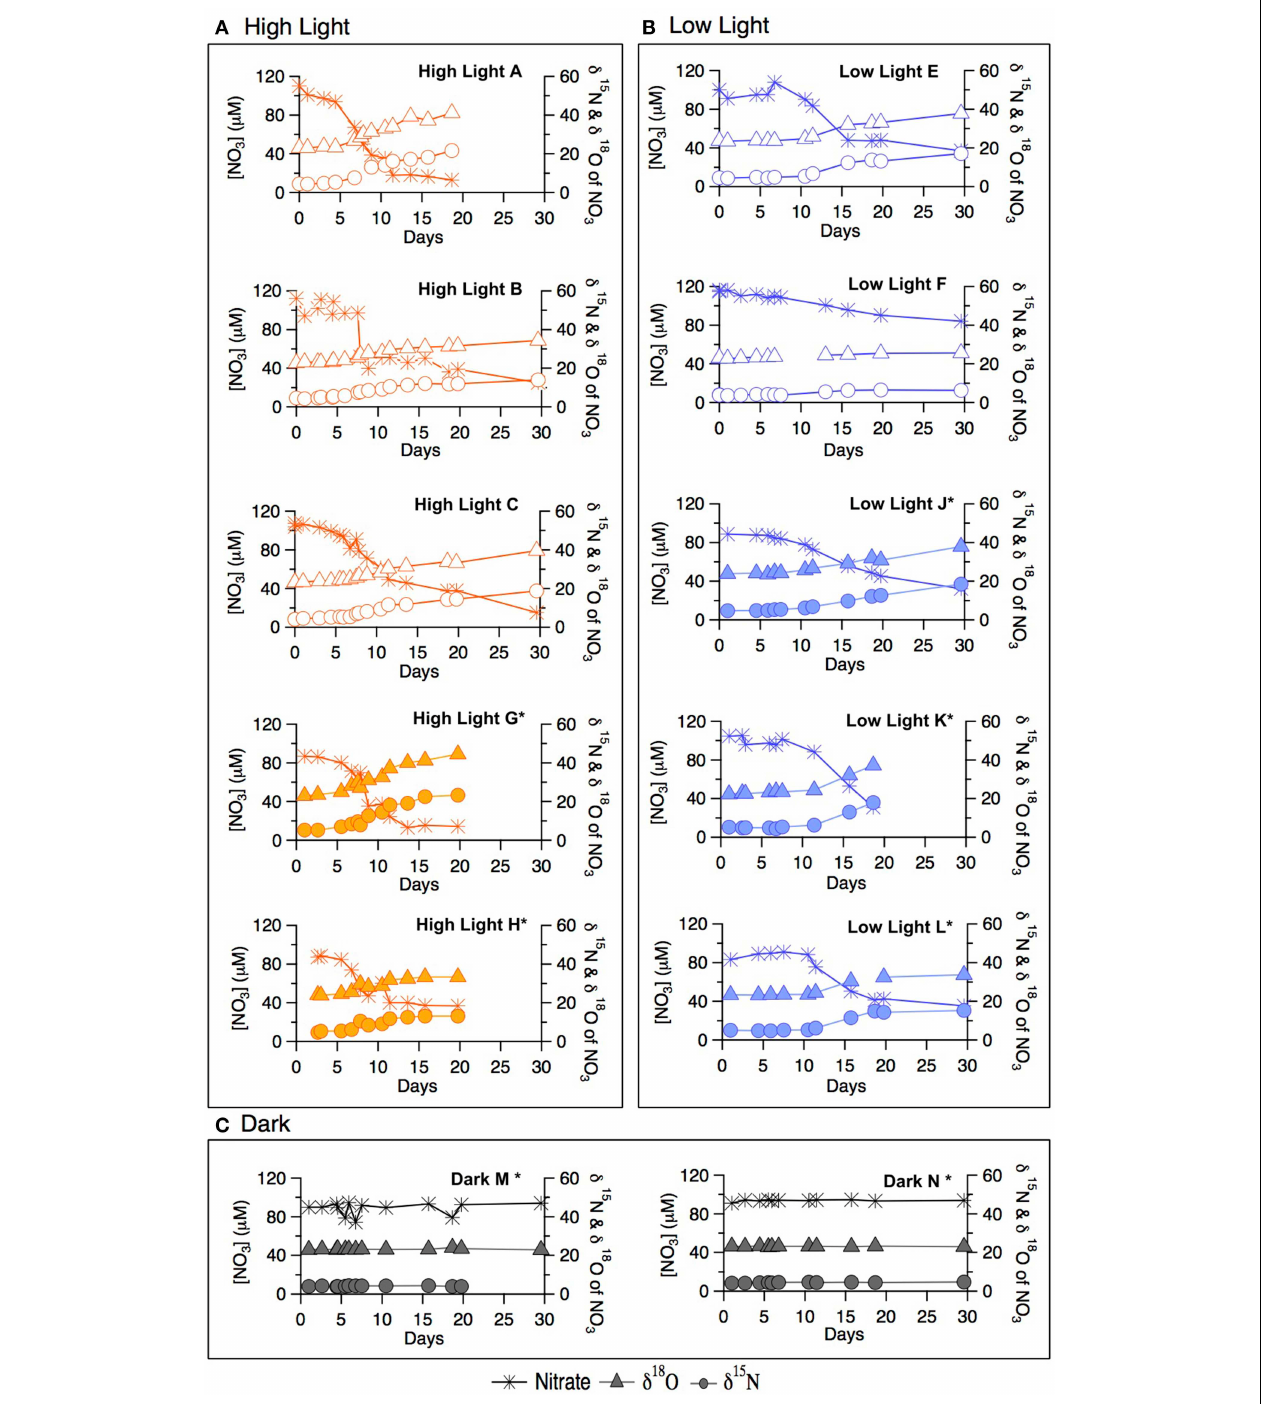
FIGURE 4 | Changes in NO − 3 concentrations during the late-summer incubations with the corresponding δ 15 N and δ 18 O of NO − 3 for (A) high-light (orange symbols), (B) low-light (blue symbols), and (C) dark treatments (gray symbols). Labeled experiments (closed symbols) are denoted by an asterisk ( * ).